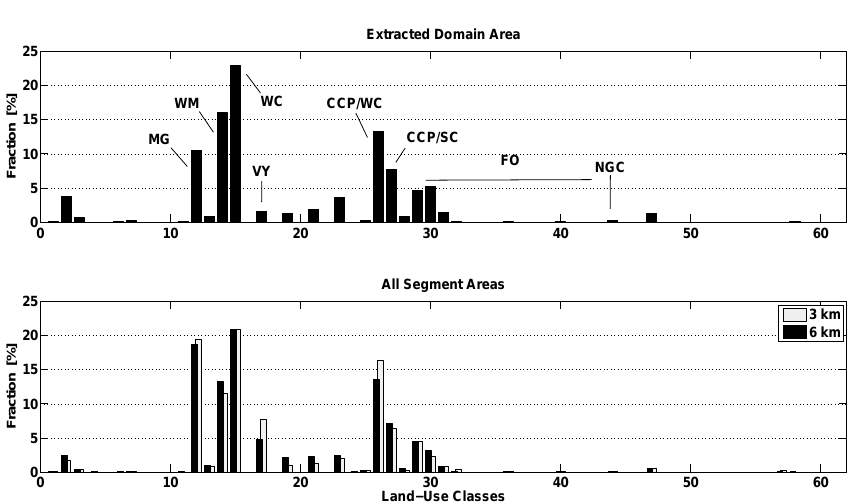
Fig. 5. Histogram of land-use classes for the extracted domain area (upper plot; see Fig. 2) and along flight track between segment 3 and 12 (lower plot) with 3-km and 6-km width at both sides at CERES’07 (See text for